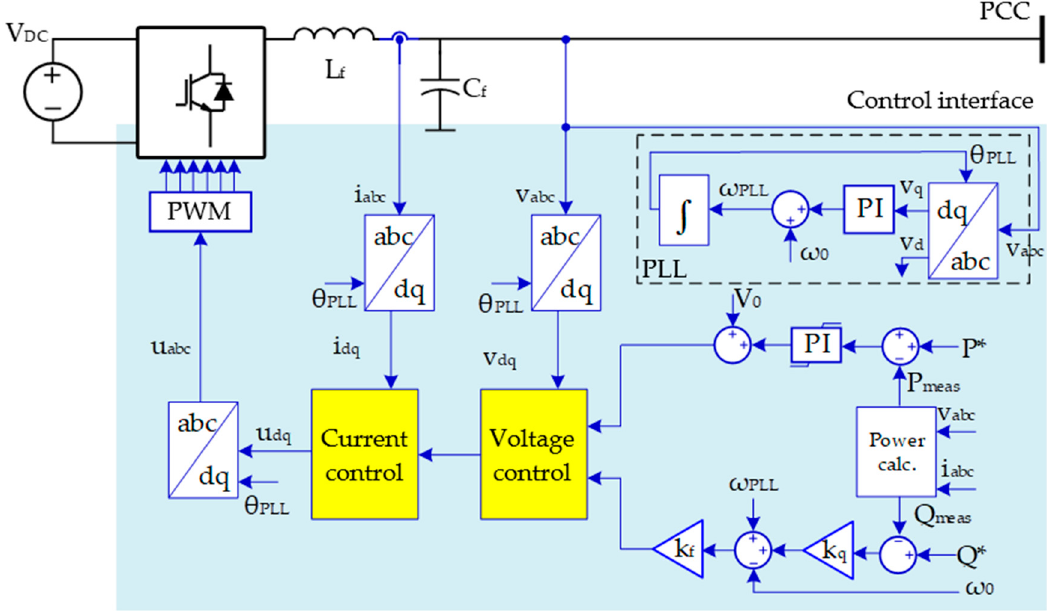
Figure 16. Distributed phase-locked loop (PLL) grid-forming control strategy from [57].